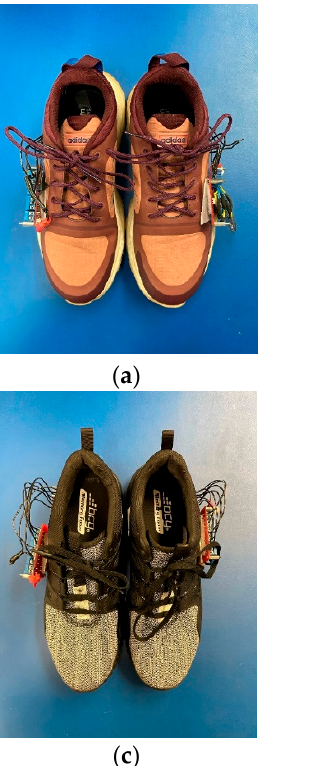
Figure 1. Schematic of the developed pressure sensor system.